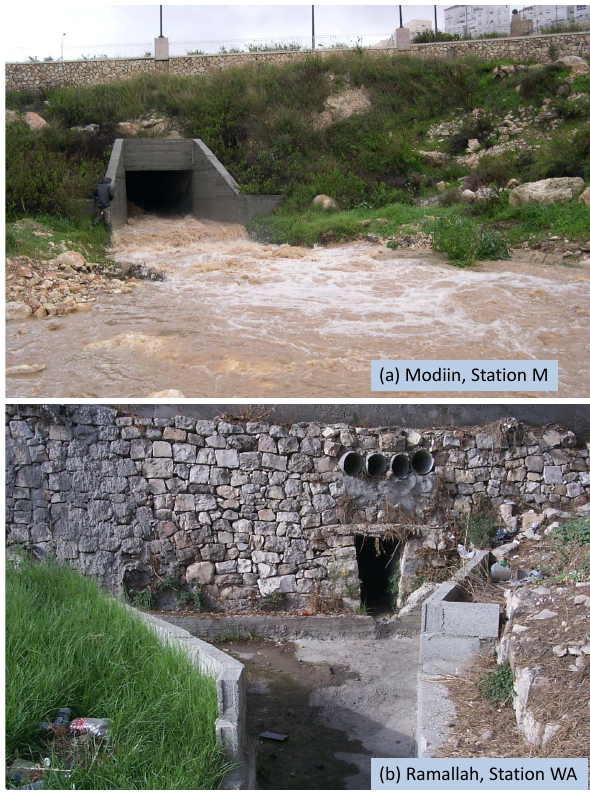
Fig. 4. The sewer culverts: (a) the outlet of the main storm water culvert in Modiin (Station M) and (b) the steep relief forced urban runoff at Station WA to concentrate at specific location (Station WA open culvert just before the gauging